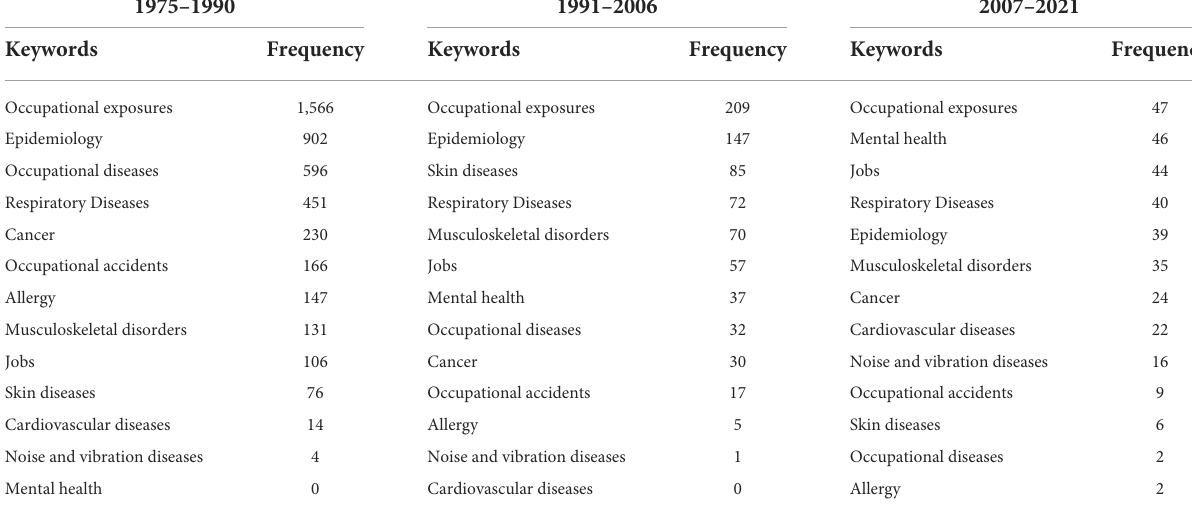
TABLE 8 Repetition of keywords over the last 15 years periods (from 1975 to